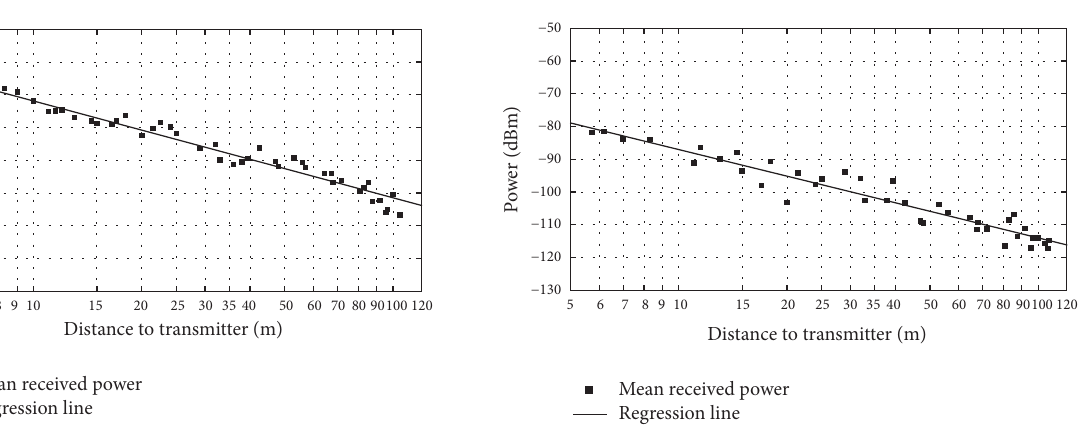
Figure 2: Pine tree, received power (dBm) versus distance in log- arithm axis, Tx front, and Rx angle LoS.